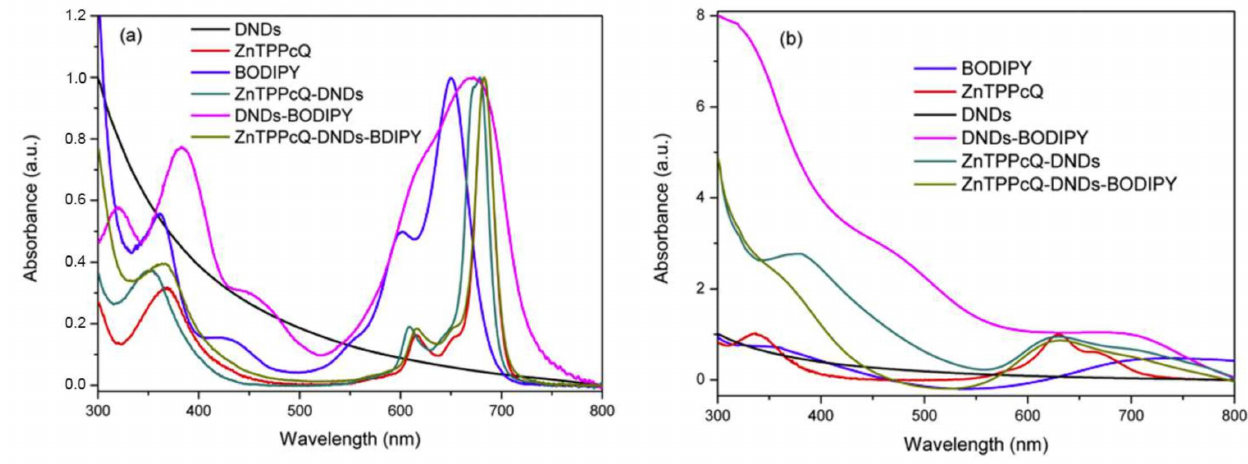
Figure 17. UV–Vis spectra of DNDs, ZnTPPcQ, BODIPY, DNDs-BODIPY and ZnTPPcQ-DND, and ZnTPPcQ-DNDs-BODIPY in ( a ) DMSO and ( b ) water (containing 1% DMSO) for all samples. Adapted from